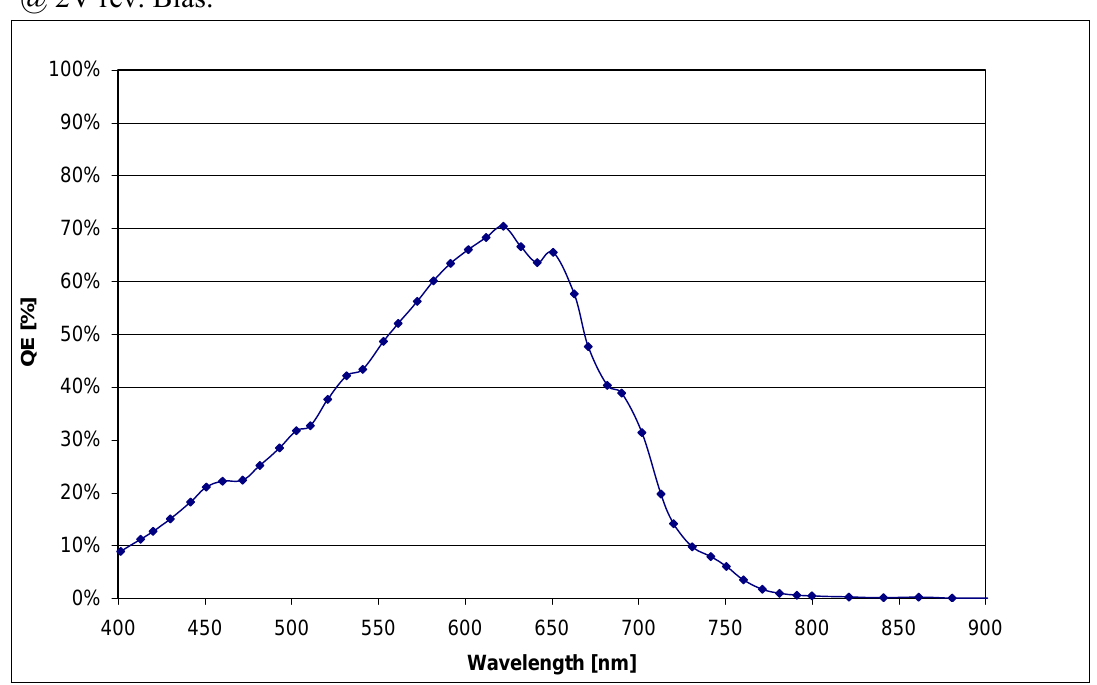
Figure 7. Quantum efficiency of a 800nm thick TFC PIN-diode. Diode area = 0.9 mm 2 @ 2V rev.